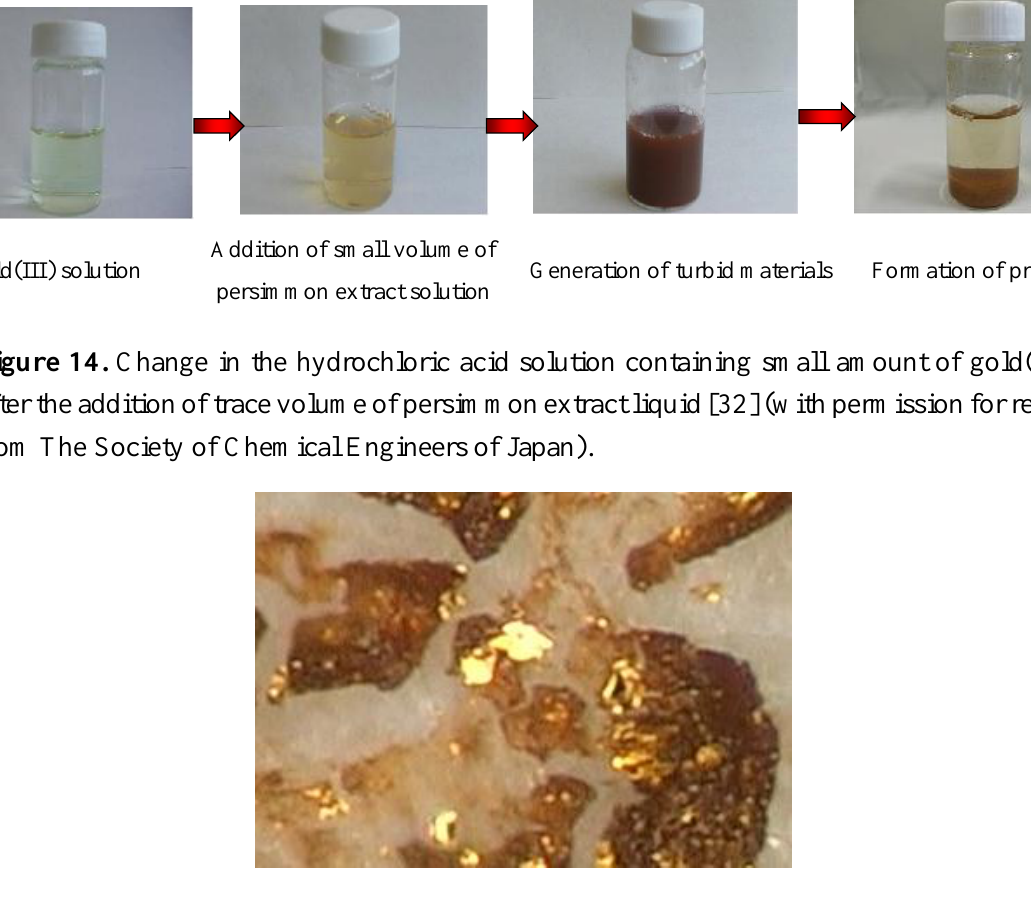
Figure 15. Image of the filter cake of the precipitate generated by the addition of persimmon extract liquor into the gold(III) solution observed by optical microscope